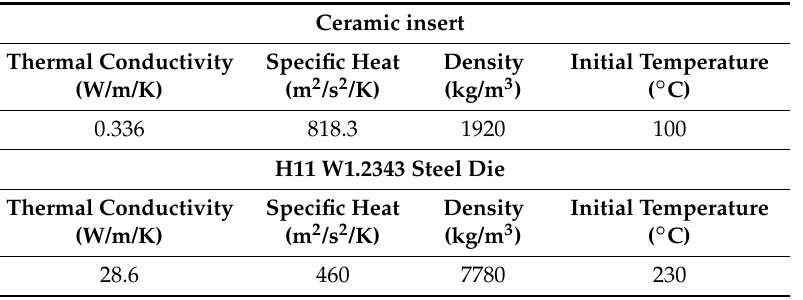
Table 3. Thermal properties of mold materials.